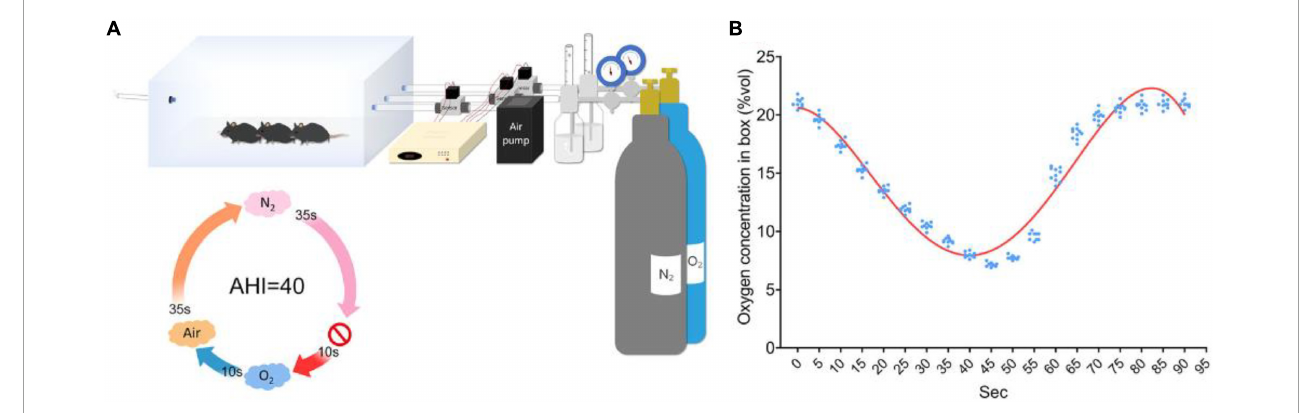
FIGURE1 Diagram of the CIH animal model established by a high/low oxygen animal culture system with an adjustable oxygen concentration. (A) Schematic of the OSA induction protocol. (B) Oxygen concentration was monitored in real time over 90-s cycles